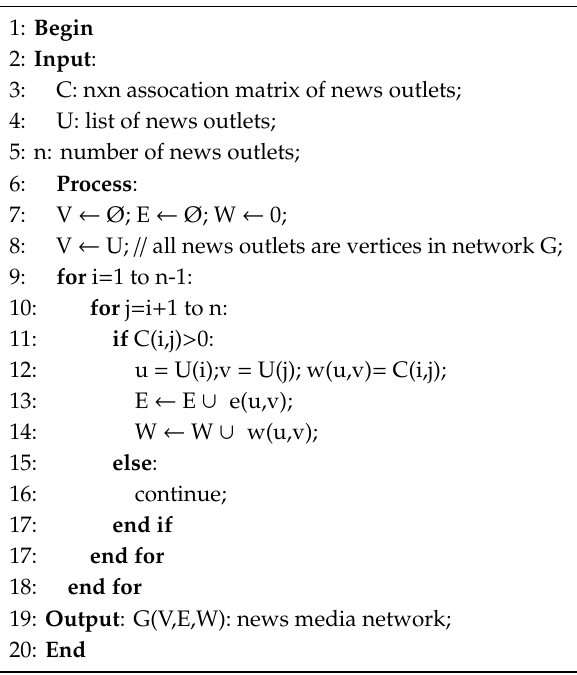
Algorithm 3 Construct news media